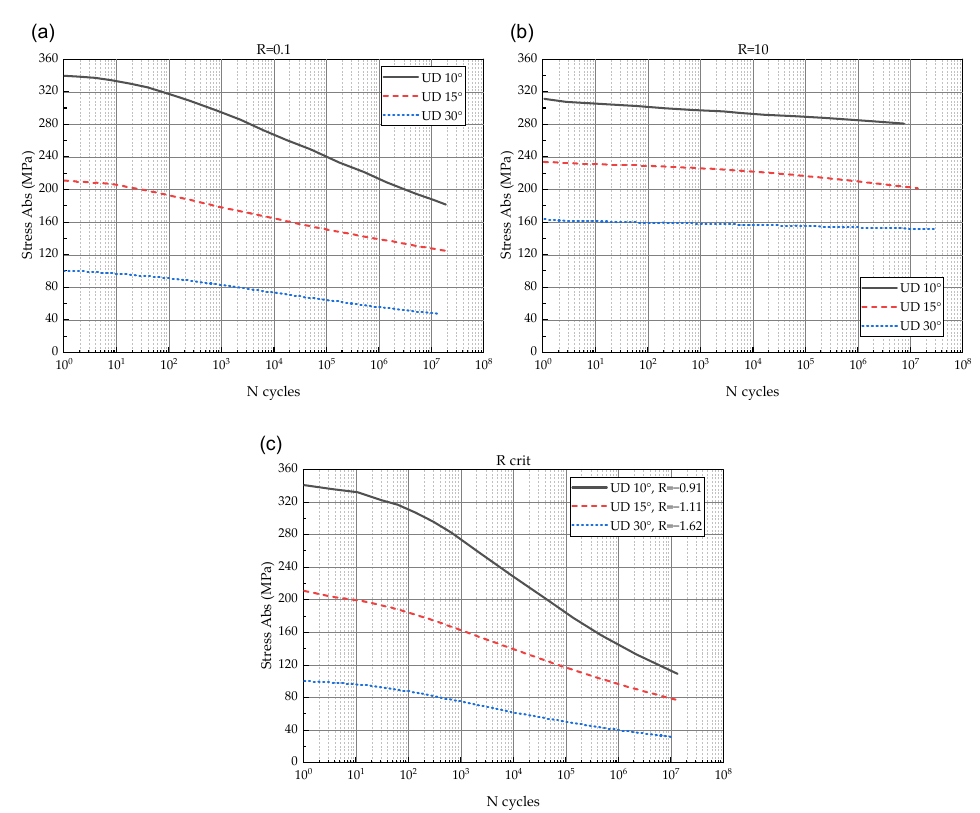
To verify the proposed FDM, we compared experimental S-N curves for UD 10 ◦ , 15 ◦ , and 30 ◦ as shown in Figure 7 with the curves predicted by the model.